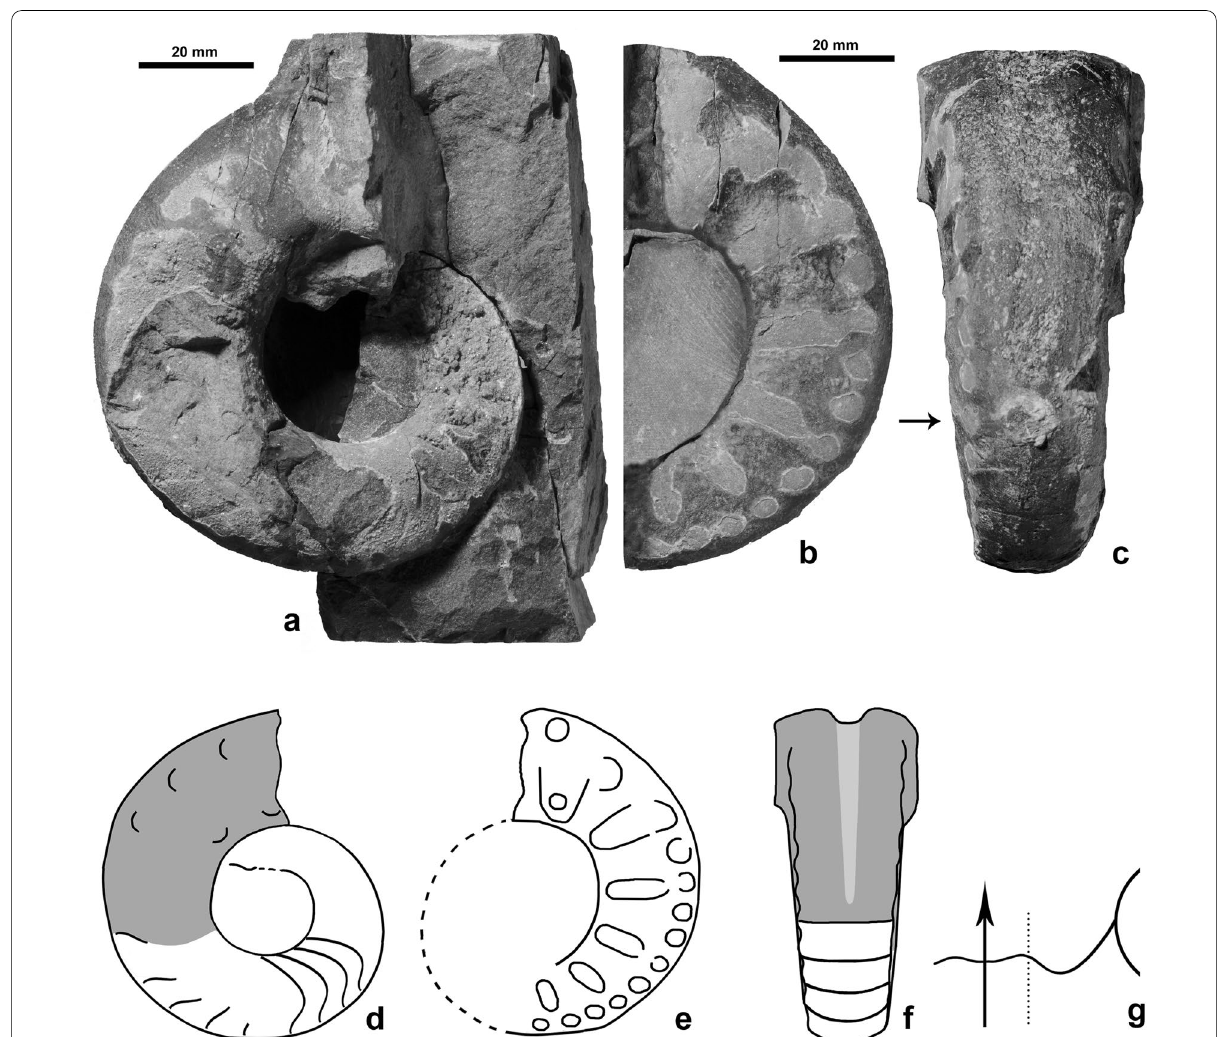
Fig. 2 Enoploceras rieberi sp. nov., PIMUZ 37902, holotype, Point 902/ Mirigioli (Monte San Giorgio), Middle Besano Formation (bed 73), Secedensis Zone, Illyrian. a lateral view, left side, b lateral view, right side, c ventral view, d drawing of the left side, phragmocone with septa (white) and body chamber (grey). e Drawing of the right side showing the sculpture, f drawing of the ventral view showing the depressed ventral area (light grey) and the hyponomic sinus, g suture